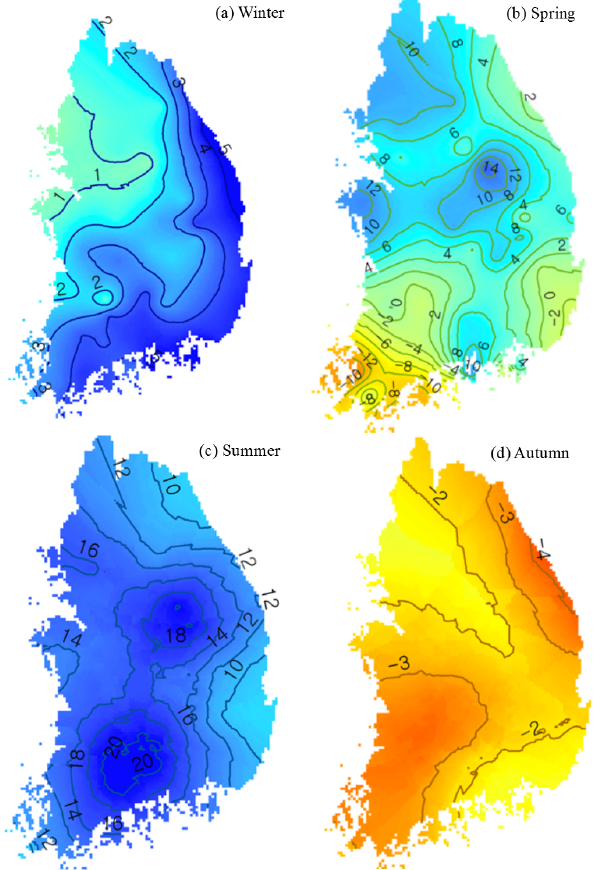
Figure 10. Spatial distributions in South Korea of the mean differ- ence in seasonal precipitation (mm) with a 1.0 ◦ C increase in mean temperature. Note that the scale for the summer distribution is dif- ferent from the other seasons, the 95% significance intervals are different at each station and the mean values of the significance in- tervals are ± 5.38, ± 15.04, ± 29.94, and ± 4.84 for Winter (De- respectively.